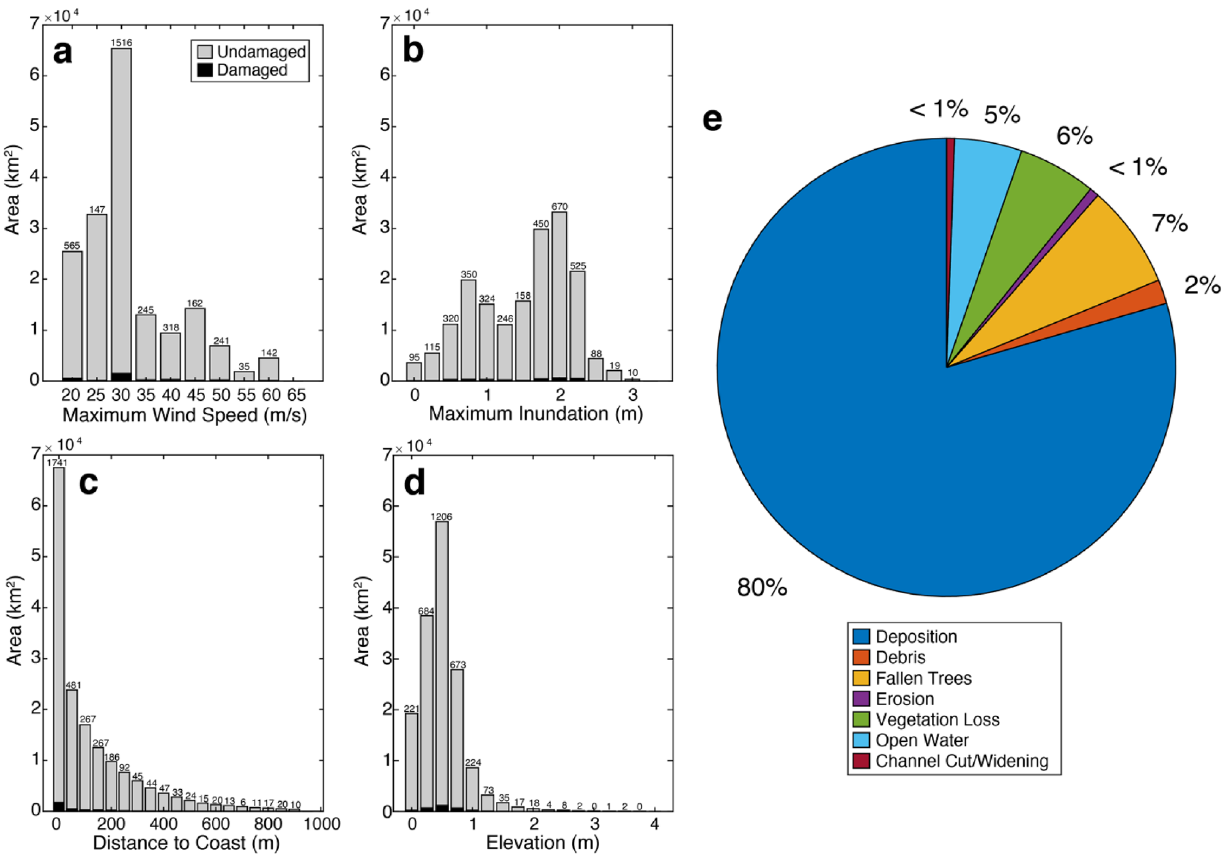
Figure 3. Marsh damage across all three study counties. Undamaged and damaged marsh area binned by ( a) maximum windspeed (m/s; 5 m/s bin width), ( b) maximum inundation (m; 0.25 m bin width), ( c) distance to coast (m; 50 m bin width), and ( d) elevation (m; 0.25 m bin width). ( e) Pie chart of damage type across marshes in all three counties. Small numbers above each column indicate the number of square kilometers of damaged marsh.